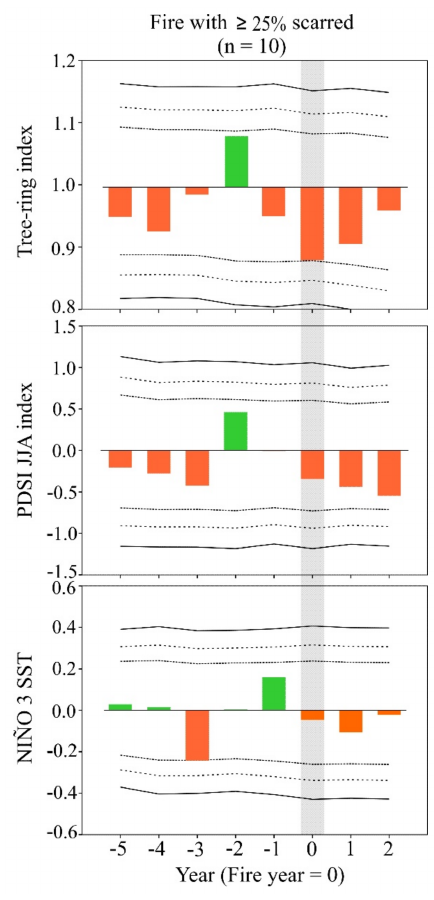
Figure 5. Superposed Epoch Analysis (SEA): Relationship between fire occurrences and regional climate (tree-ring index), PDSI (for the months June, July and August) and NIÑO 3 (Sea Surface